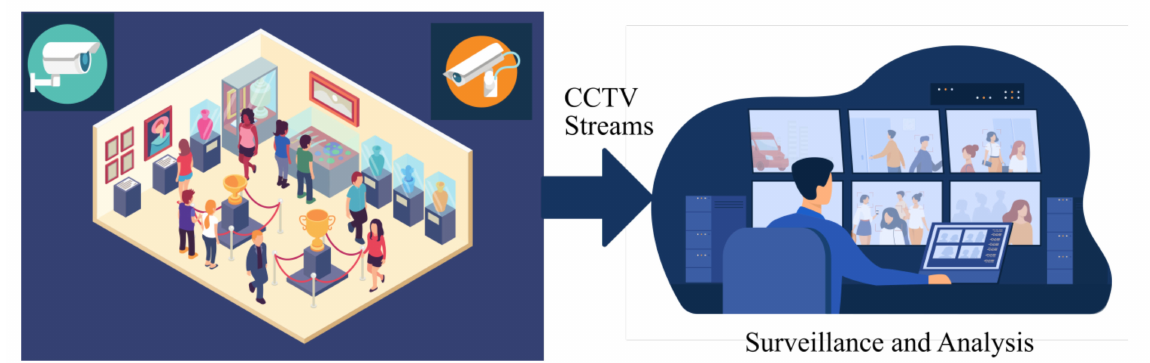
Figure 1. The proposed ARTifact popularitY for CULtural heritage (ARTYCUL) system and its position in a CCTV monitored premise.